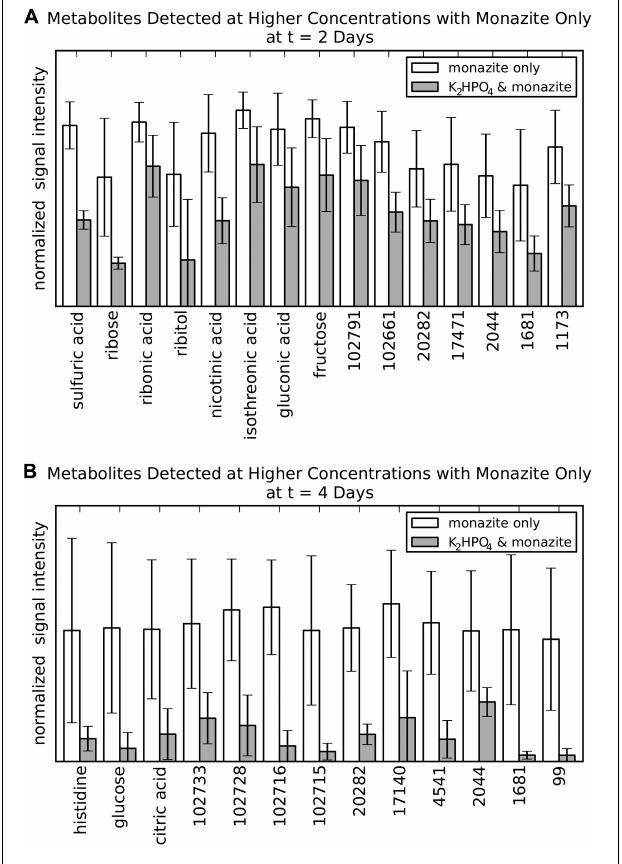
FIGURE 3 | Metabolites of potential bioleaching importance identified by occurrence at higher concentrations in the monazite-only condition compared to K 2 HPO 4 plus monazite. (A) Metabolites identified at 2 days. (B) Metabolites identified for at 4 days. Signal intensities are normalized as the fraction of the maximum observed signal intensity for each metabolite at that time point. Height and error bars indicate mean and standard deviation for six biological replicates. Metabolites selected based on a marginally significant Benjamini/Hochberg adjusted p -value < 0.1. This less stringent p -value criterion was used at this intermediate stage only, in order to identify a large number of metabolites for the abiotic leaching